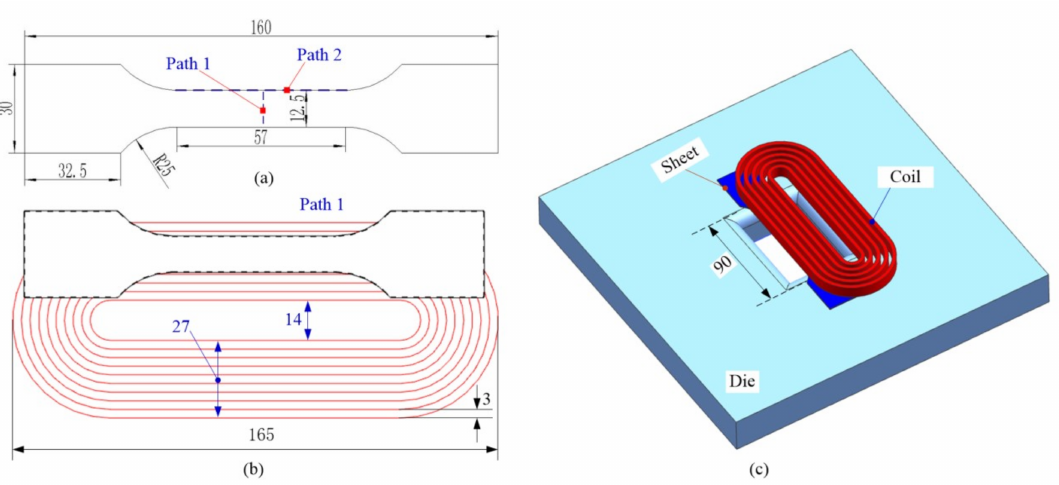
Figure 1. Schematic diagram of magnetic-pulse bending: ( a ) sample structure, ( b ) relative position of coil and sample, and ( c ) 3D structure of the forming process. Units: